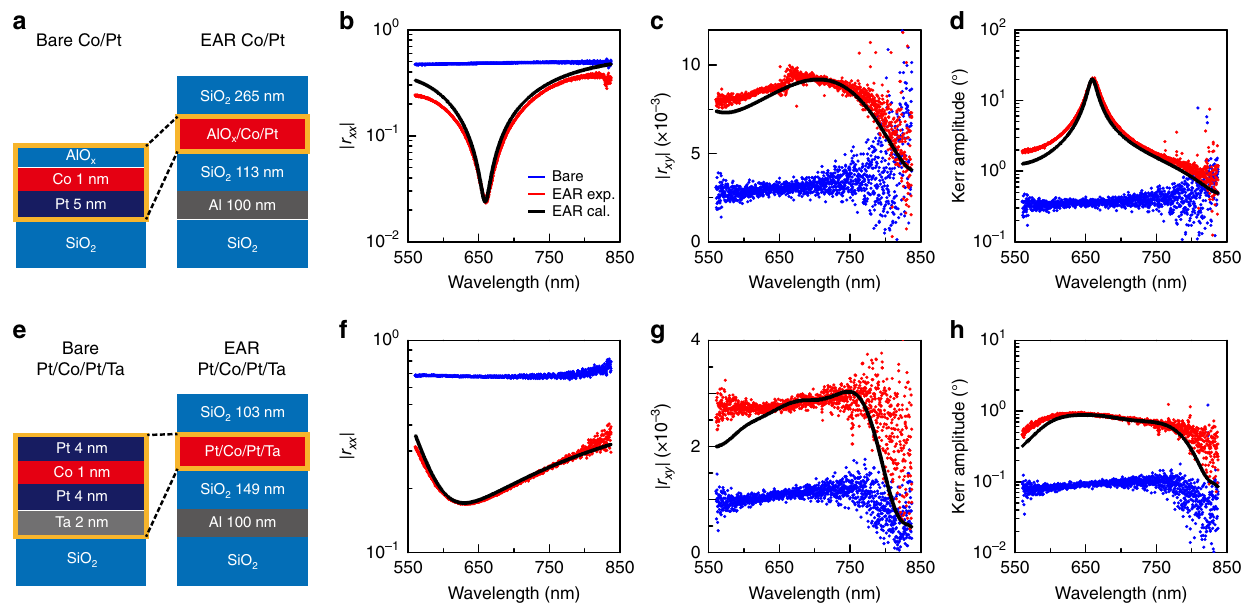
Fig. 2 Experimental demonstration of EAR-enhanced MOKE. a Schematics of the bare and EAR Co/Pt layers. b – d Measured spectra of the non-MO re fl ection amplitude | r xx |, MO re fl ection amplitude | r xy |, and Kerr amplitude from the bare and EAR Co/Pt layers. e Schematics of the bare and EAR Pt/Co/ Pt/Ta layers. f – h Measured spectra of the non-MO re fl ection amplitude | r xx |, MO re fl ection amplitude | r xy |, and Kerr amplitude from bare and EAR Pt/Co/ Pt/Ta layers. We also calculated the non-MO and MO re fl ection amplitudes and the Kerr amplitude of the EAR Co/Pt and EAR Pt/Co/Pt/Ta fi lms using the transfer matrix method (black solid